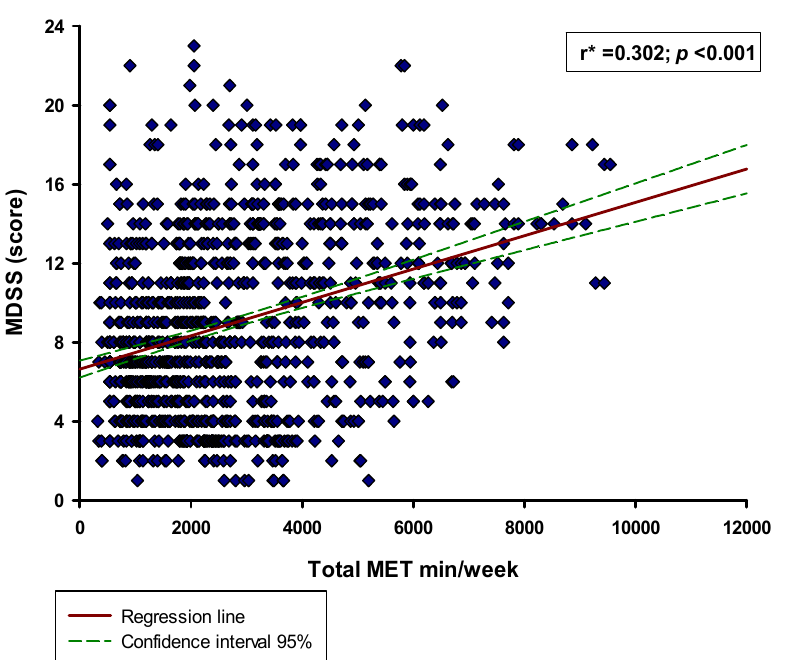
Figure 1. Histogram showing the MDSS score in the study sample ( n = 1220).